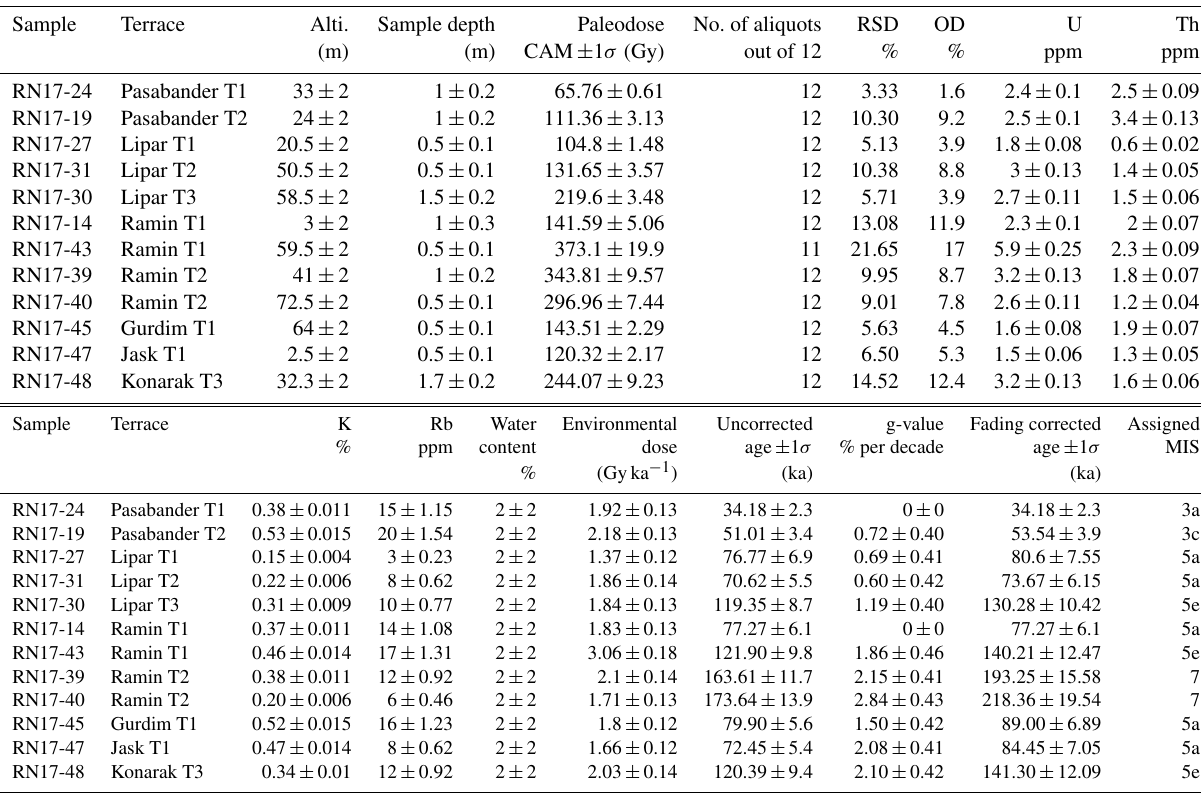
Table 2. Results and details of OSL dating and assigned MIS. RSD: relative standard deviation; OD: overdispersion. Sample